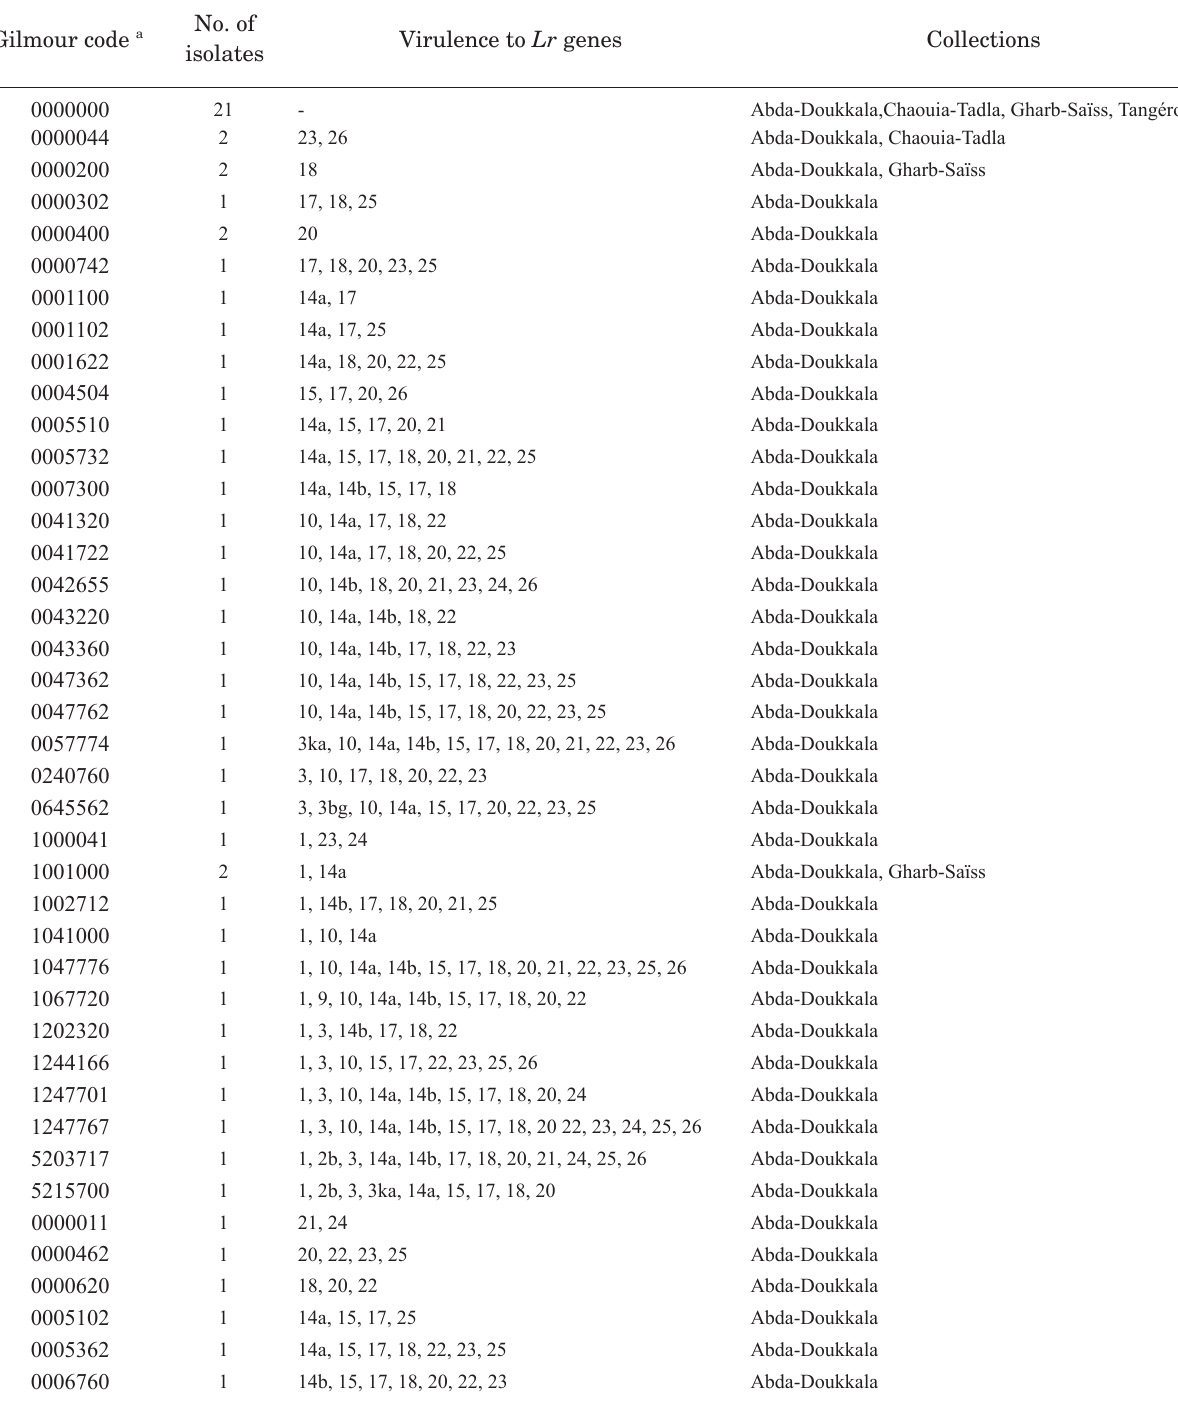
Table 1. Virulence phenotypes of Puccinia recondita isolates collected from durum and common wheat in Abda- Doukkala, Chaouia-Tadla, Gharb-Saïss, and Tangérois a .